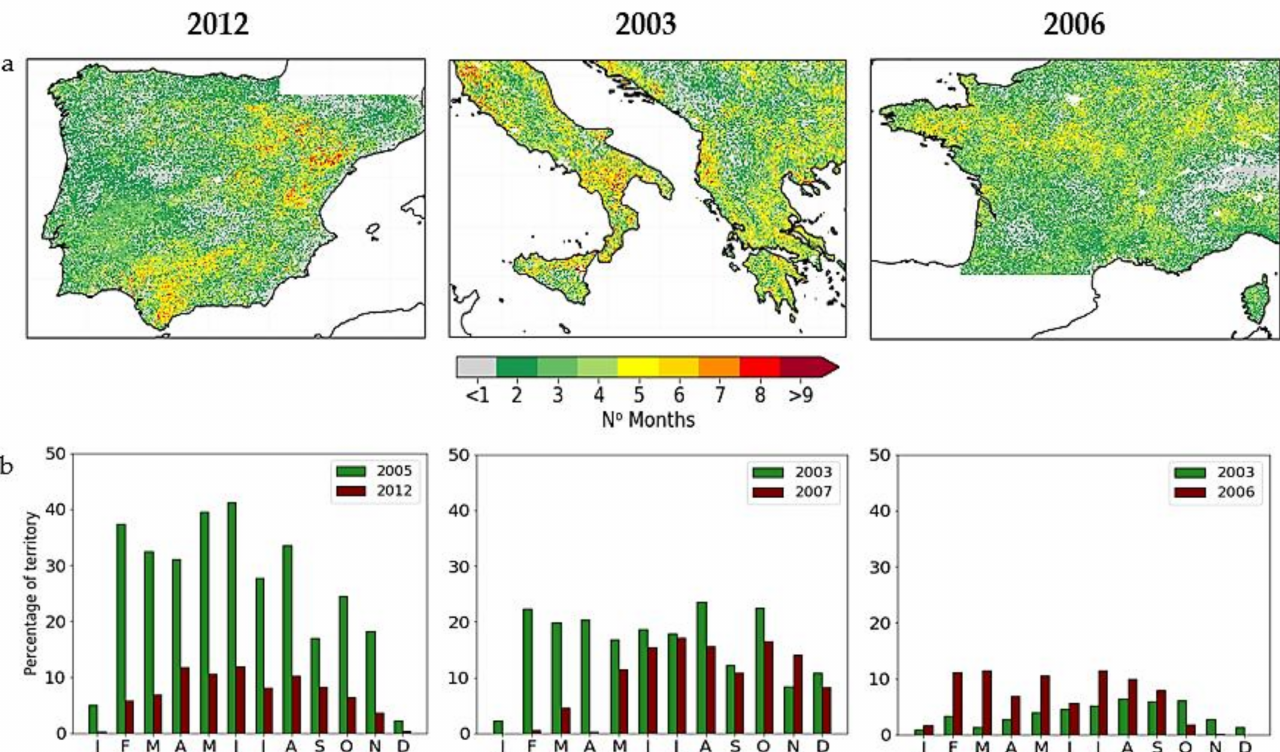
Figure A1. As in Figure 2, but over IB during 2012 event (left panels), EM during 2003 event (central panels) and WE during 2006 event (right